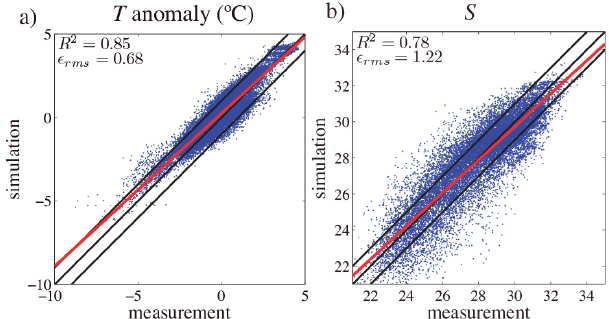
Figure 8. Scatter plots of measured vs. simulated (a) temperature (every 30min), (b) salinity (every 30min). The red lines correspond to a linear regression. The centre black line represents the ideal linear regression (simulation = measurement), while the side black lines are the ideal regression ± 1. For every plot the coefficient of determination ( R 2 ) and the rms error (cid:15) min are